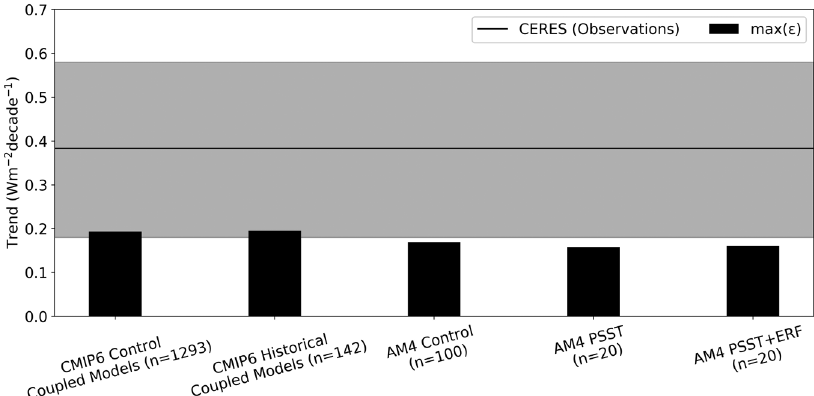
Fig. 2 Global-mean observed trend in Earth ’ s energy imbalance (EEI) is unexplained by internal variability. Each model ensemble ’ s estimate of maximum trends in Δ EEI due to internal variability ( ϵ ) is plotted. See Supplementary Tables 1 – 2 for the number of realizations ( n ; two-decade periods trends) for each model in Coupled Model Intercomparison Project Phase 6 (CMIP6) Control and CMIP6 Historical ensembles. Gray shading represents observational uncertainty. Note that although there is a small overlap between the high trends due to internal variability and the low trends due to observational uncertainty, the probability that both events happen in the same two-decade period is less than 1%; see text and see “ Methods ” section for details. CERES = Clouds and the Earth ’ s Radiant Energy System satellite observations (black), AM4 PSST = Prescribed Sea Surface Temperatures (SSTs) and sea ice with forcing agents held fi xed at 2014 levels in Geophysical Fluid Dynamics Laboratory Atmosphere Model 4 (AM4), and AM4 PSST + ERF = same as AM4 PSST but with effective radiative forcing changes (ERF; forcing agents